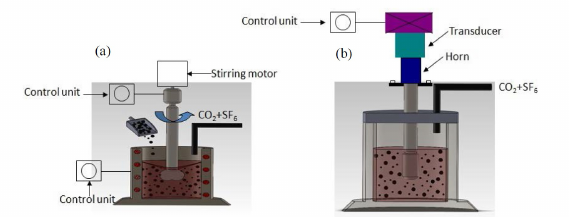
Figure 1: Schematic diagram to fabrication of MMC by using stirring